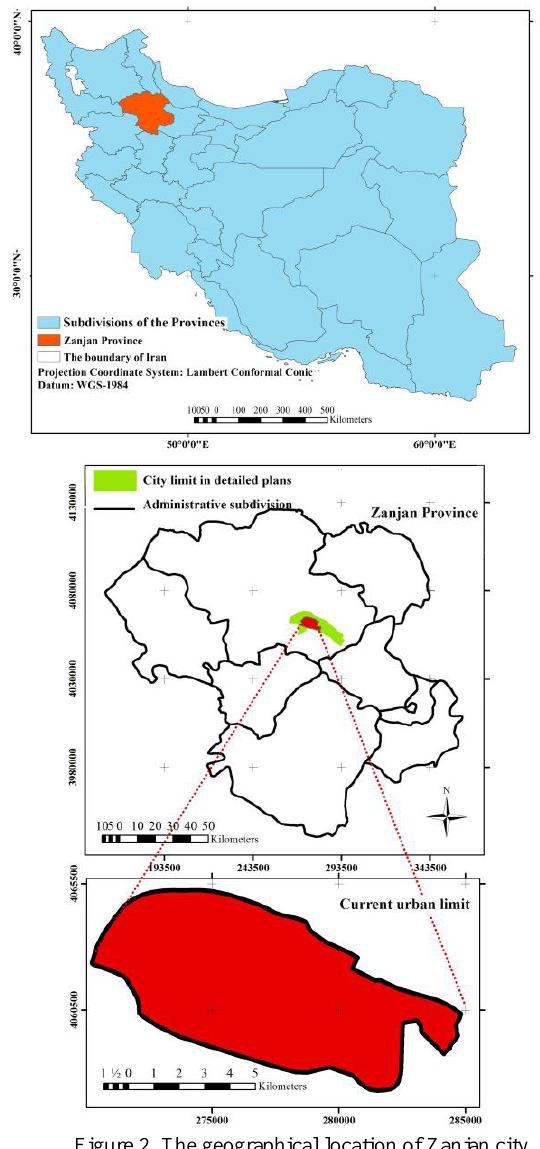
Figure 2. The geographical location of Zanjan city